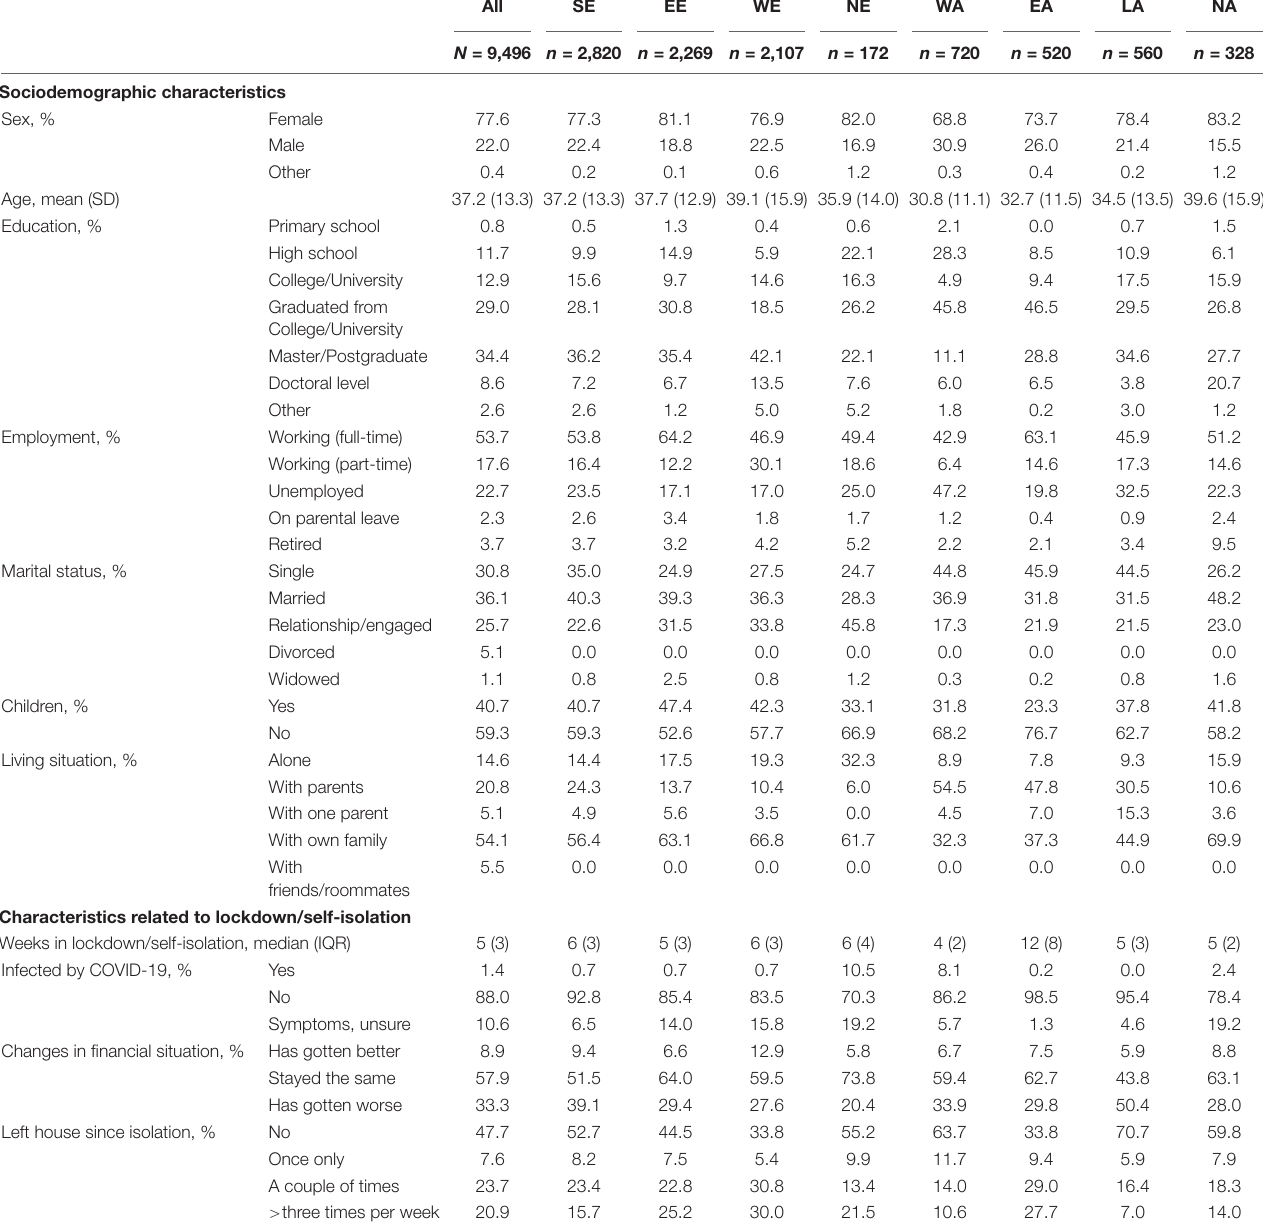
TABLE 1 | Sociodemographic and characteristics related to quarantine/self-isolation of the total sample and subsamples of each region. All SE EE WE NE WA EA